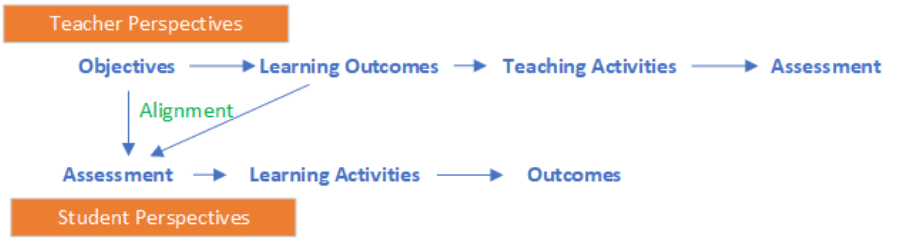
Figure 1. Student and teacher perspectives in Higher Education (HE) learning activities [2].